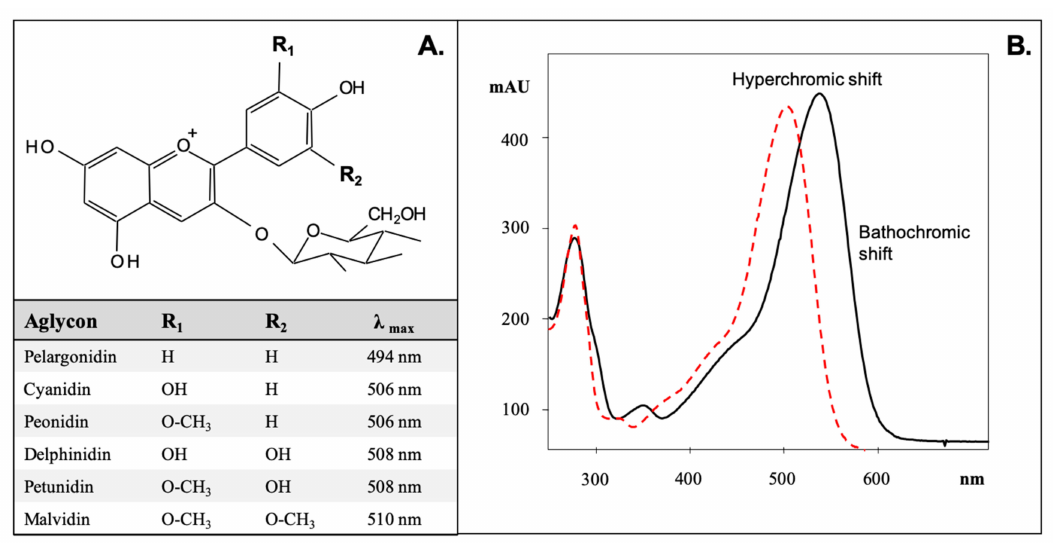
Figure 1. Anthocyanidins commonly found in nature, their B-ring conjugations, and maximum absorbance ( A ). Bathochromic and hyperchromic shifts produced by acylation of anthocyanins ( B ).